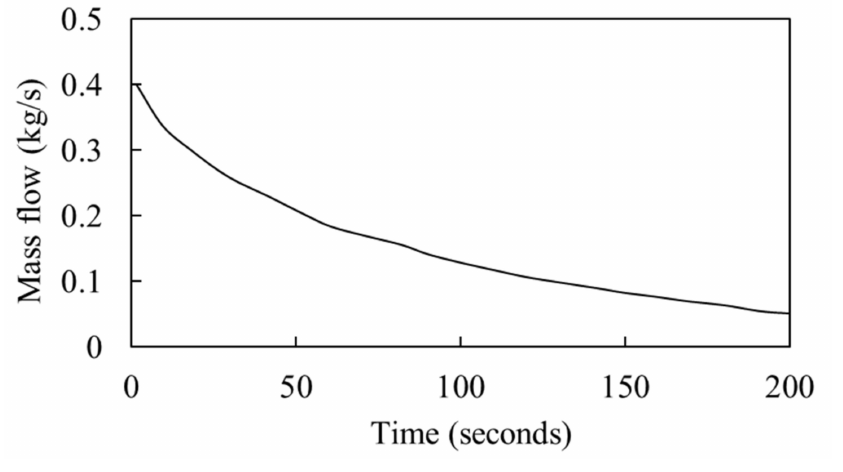
Figure 3. Discharge mass flow